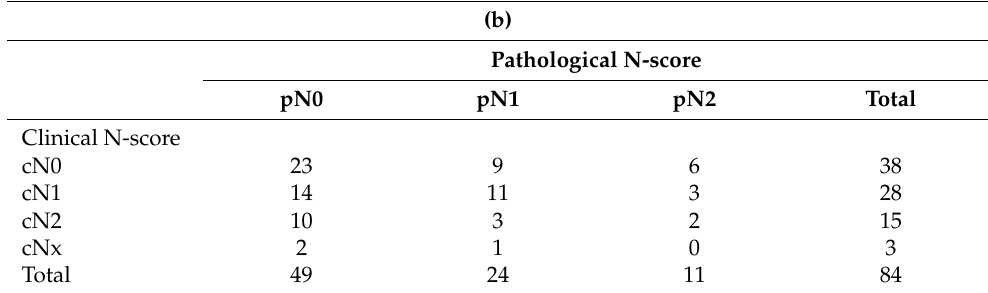
Table 5. Cont . (b) Comparison of clinical and pathological nodal staging in patients treated with AC.